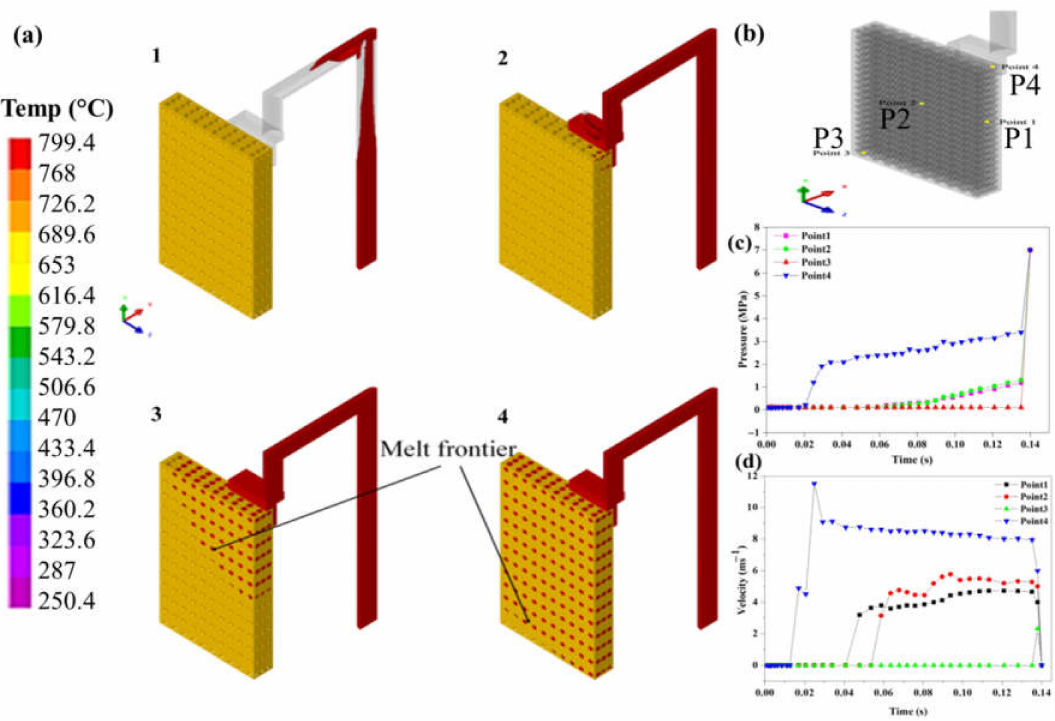
Figure 2. ( a ) The filling process: (1) t = 0.0048 s melt entering the runner, (2) t = 0.0205 s starting filling SiC, (3) t = 0.0587 s filling SiC, and (4) t = 0.1351 s filling SiC; ( b ) the distribution of nodes; ( c ) the pressure in the four nodes in the filling process; ( d ) the velocity in the four nodes in the filling